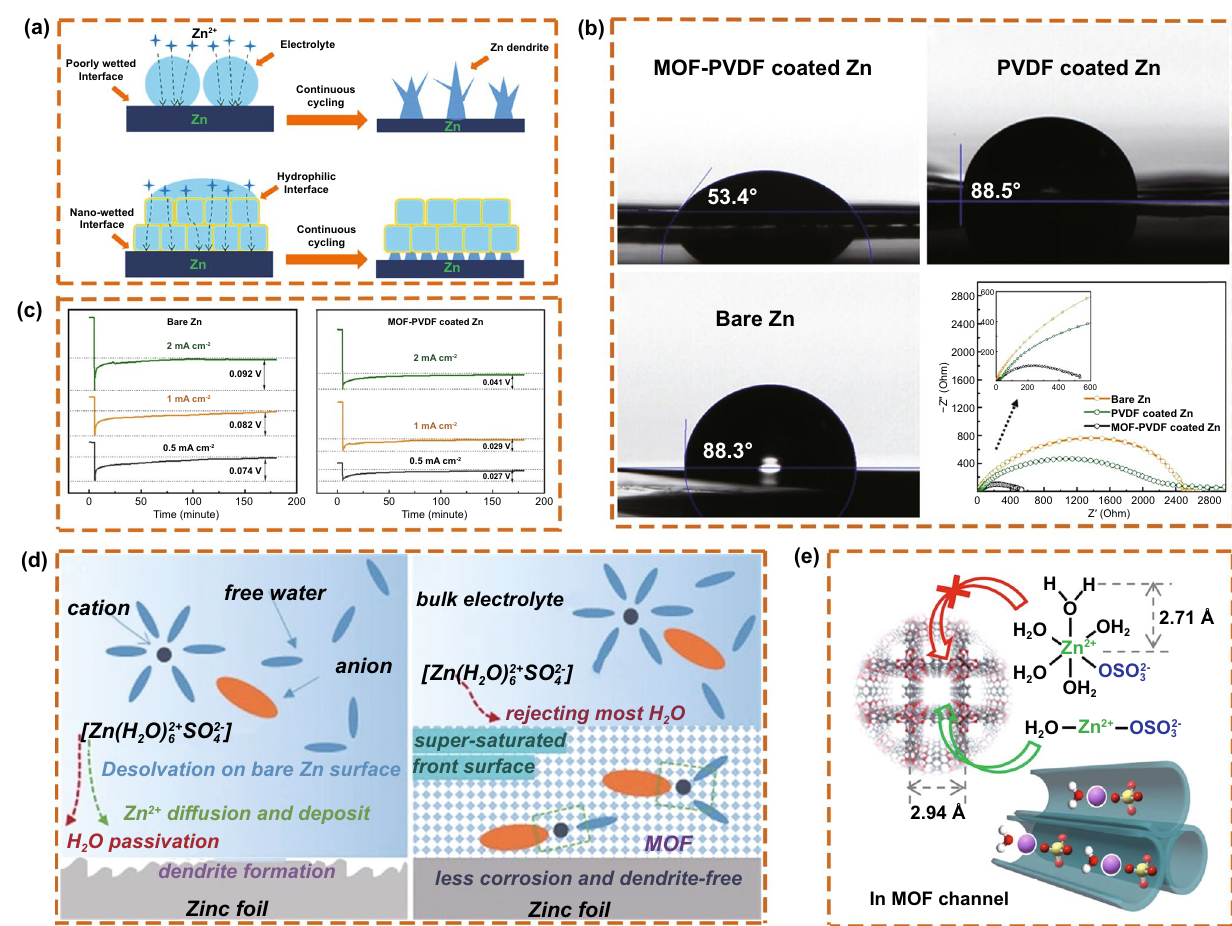
Fig. 12 a Proposed Zn plating mechanisms on bare Zn and MOF-PVDF-coated Zn. b Images of contact angles between the electrolyte and dif- ferent anodes, and electrochemical impedance spectra of Zn symmetrical cells with different anodes. c Voltage curves of Zn plating on bare Zn and coated Zn at various current densities. Copyright 2019 American Chemical Society [105]. d Schematic illustration of the Zn surface evolu- tion. e Schematic illustration of the highly-coordinated ion complexes of H 2 O-Zn 2+ ·OSO 32− migrating through MOF channels. Copyright